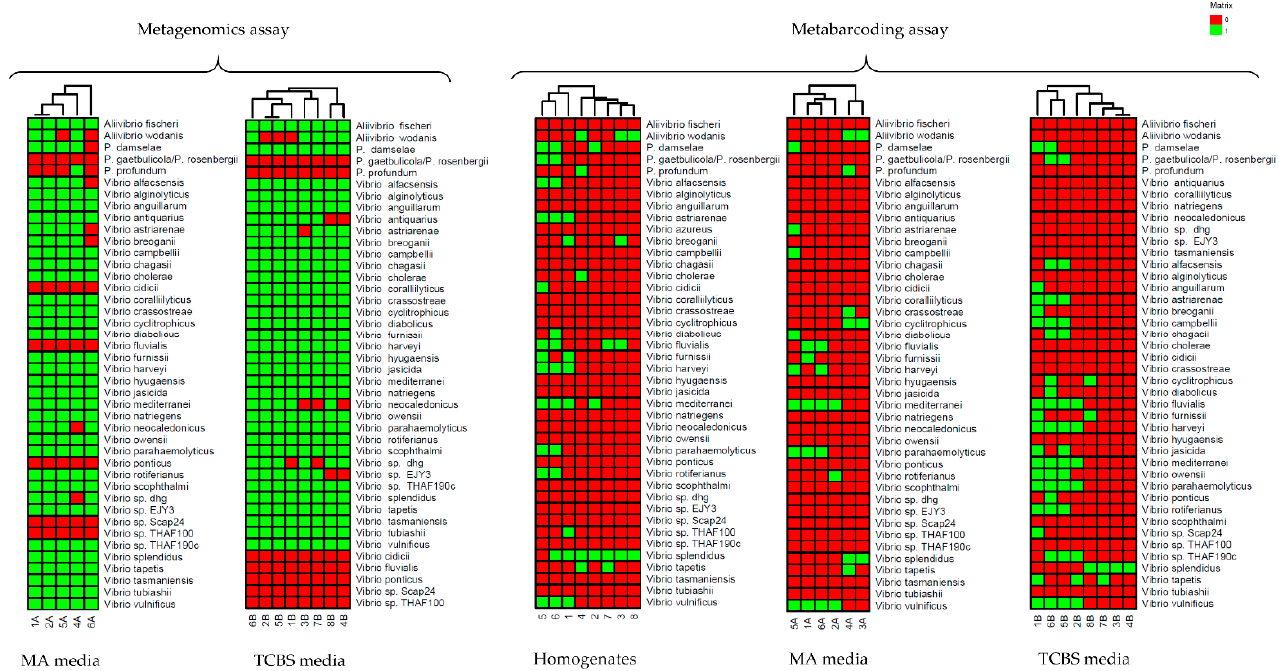
Figure 6. Heat map showing the presence (green) and the absence (red) of Vibrios found in clam samples (homogenates and clam samples plated on MA and TCBS media) according to shotgun metagenomics and rec A ‐ pyr H metabarcoding. The letter “A” is assigned to samples plated on marine agar (MA) medium; the letter “B” is assigned to samples plated on thiosulfate ‐ citrate ‐ bile salts ‐ sucrose agar (TCBS) medium. A number code (from 1 to 8) is assigned to each homogenate sample. P.: Photobacterium